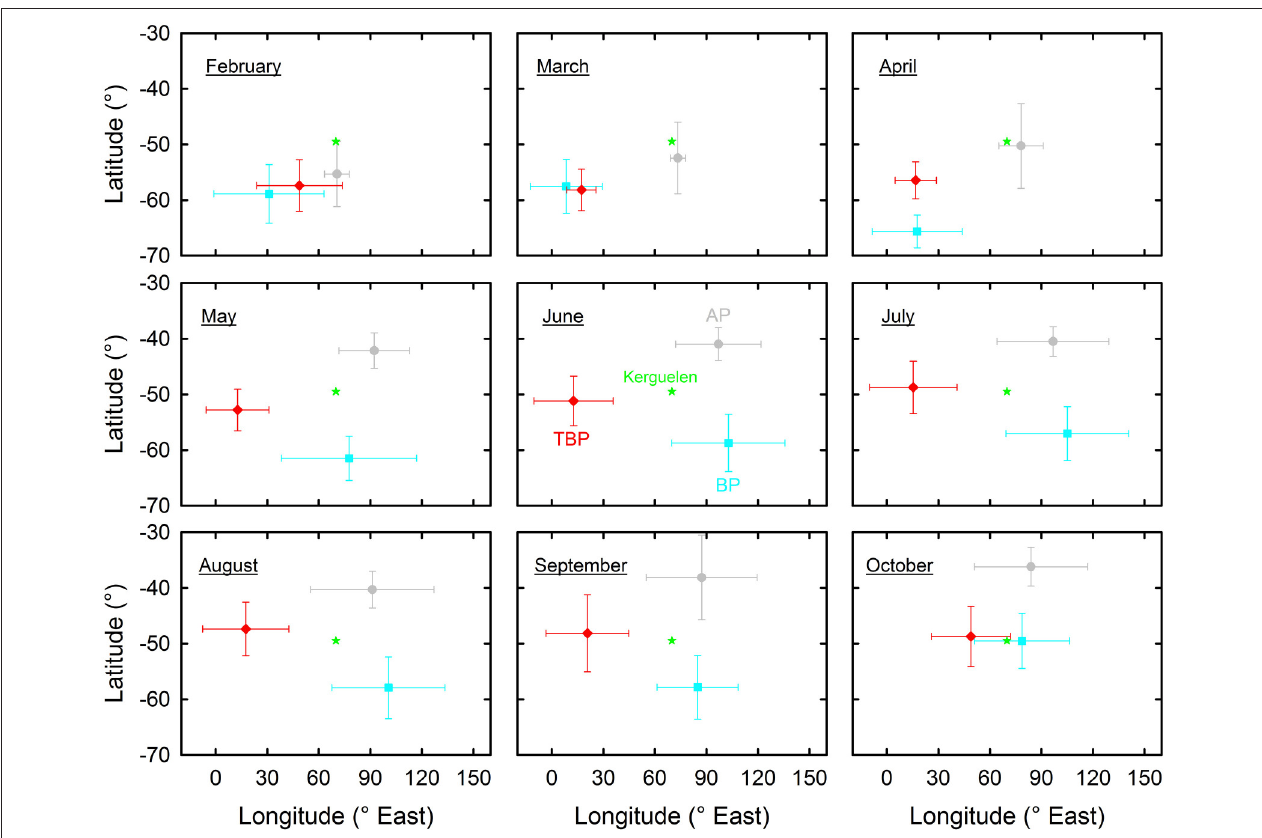
FIGURE 2 | Geographical location at sea (latitudes vs .longitudes) of Antarctic (AP, gray) and thin-billed (TBP, red) prions and of blue petrels (BP, blue) over nine successive months encompassing the whole inter-breeding period. Values are means ± SD of pooled daily locations of all the birds that were equipped with miniaturized saltwater immersion